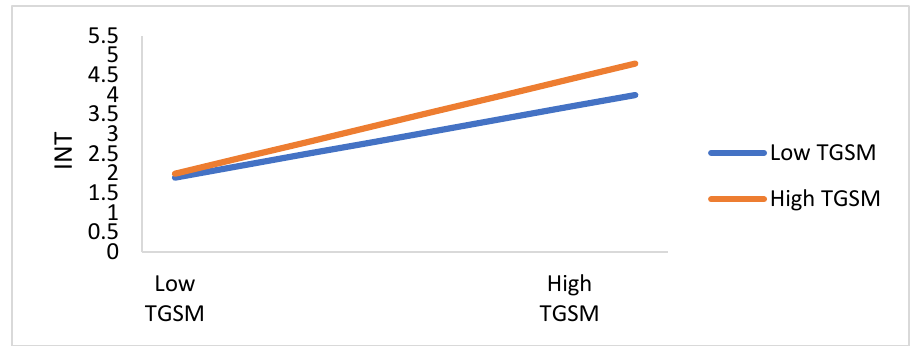
Figure 7. The plot of the moderating effect of health infodemics on the relationship between TRSM and INT.